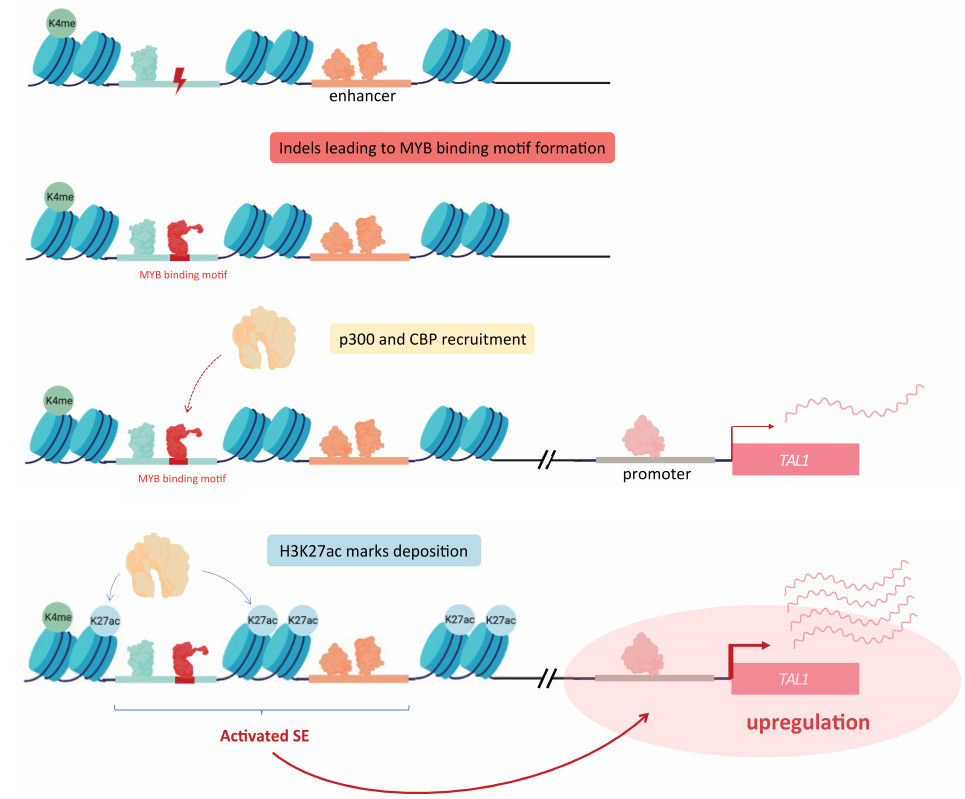
Figure 3. Indels inducing the introduction of MYB binding sites near TAL1. Somatic mutations acquired within a SE located near the TAL1 oncogene allow the production of MYB binding sites. Accumulation of MYB at these sites is responsible for the recruitment of p300 and CBP, leading to the deposition of H3K27ac marks and SE activation. Altogether, this results in the overexpression of the associated gene, here being TAL1 .